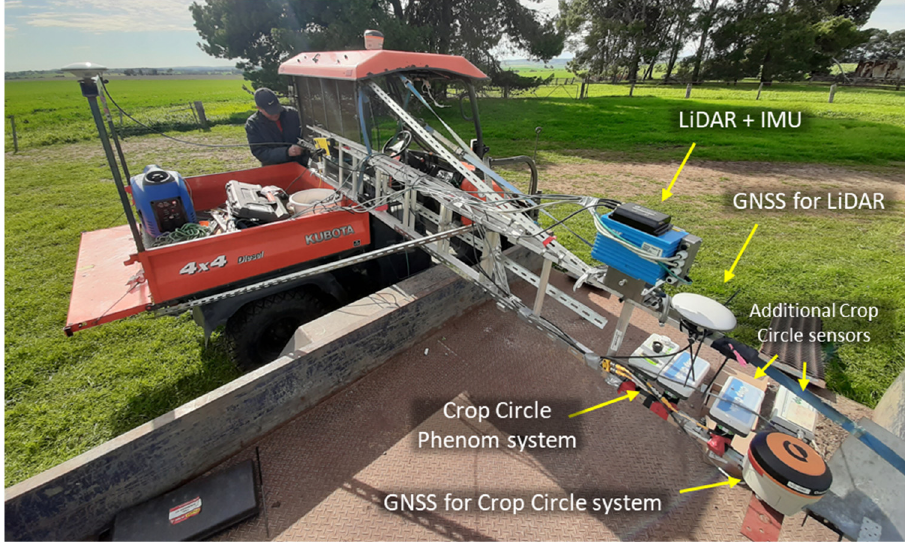
Figure 3. LiDAR and reflectance sensors mounted on an all-terrain vehicle for crop scanning.